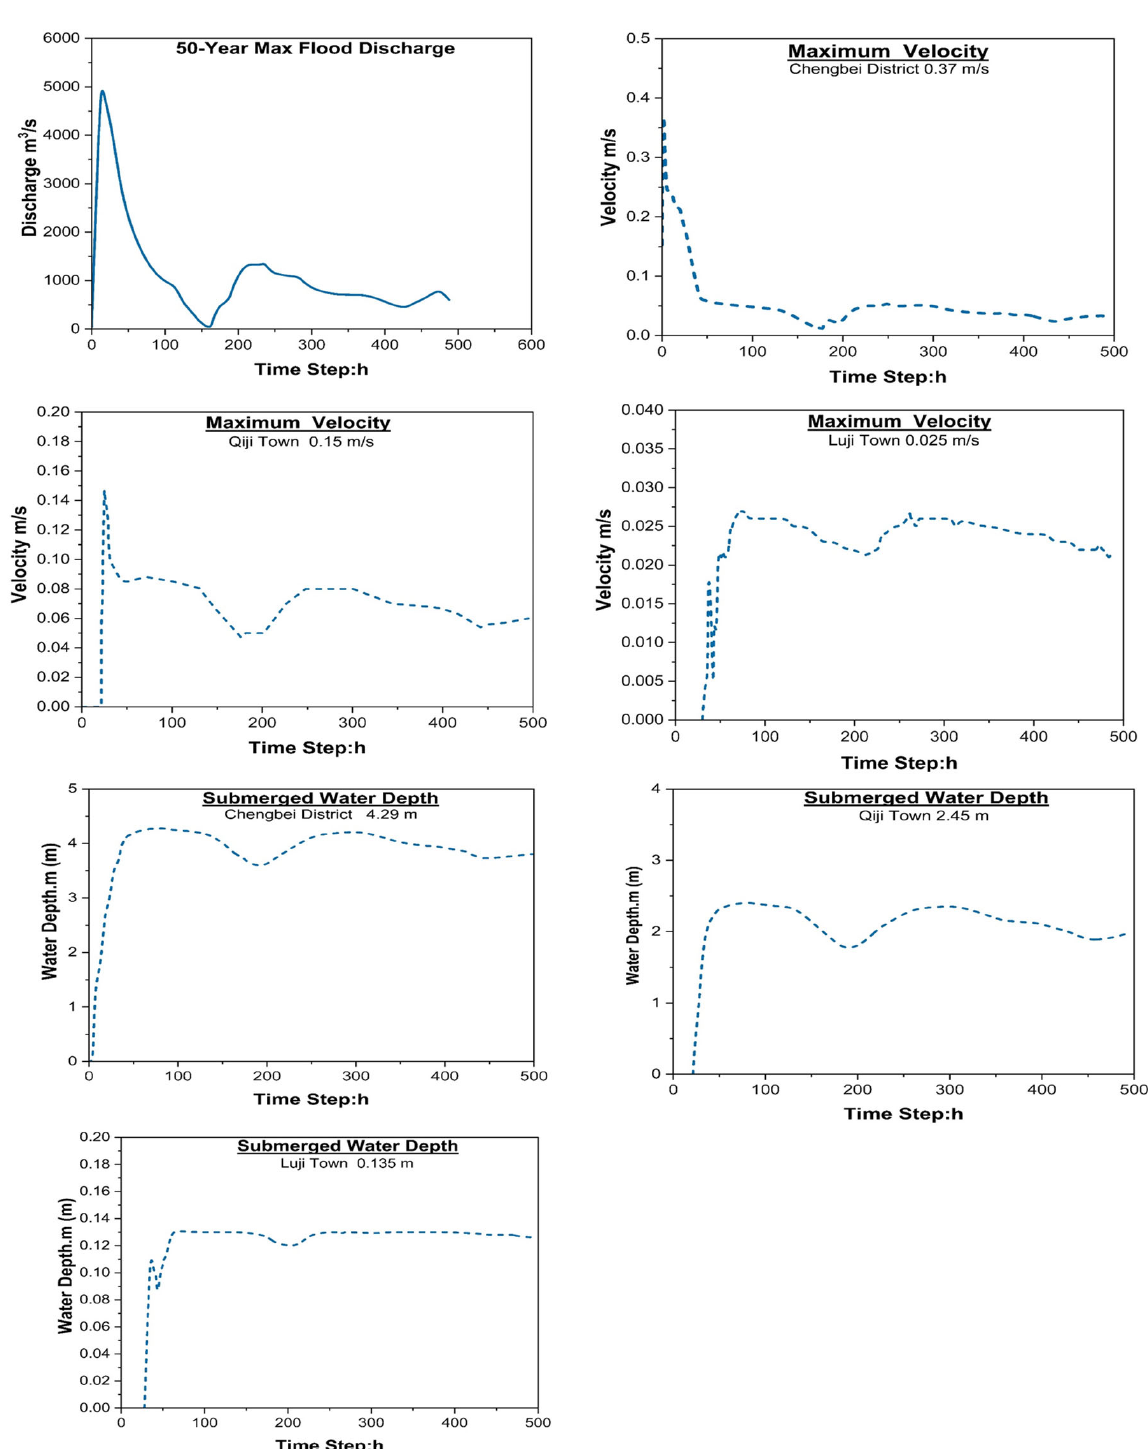
Figure 5. Frequency of flood discharge, velocity, and submerged water depth graphs of 50-year flood at Chengbei District, Qiji Town, and Luji Town.